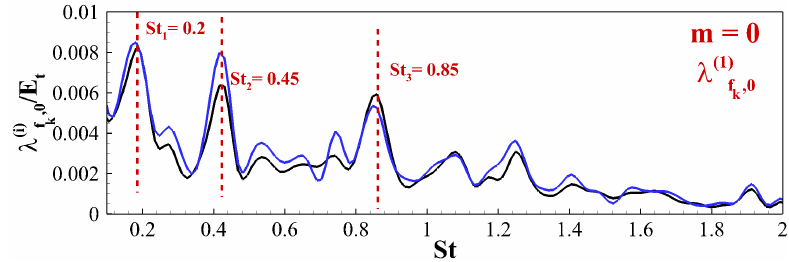
Figure 9. SPOD eigenvalues normalised by total flow energy as a function of Strouhal number for the first azimuthal mode number calculated for the total (black line) and 75% of the dataset (blue line).